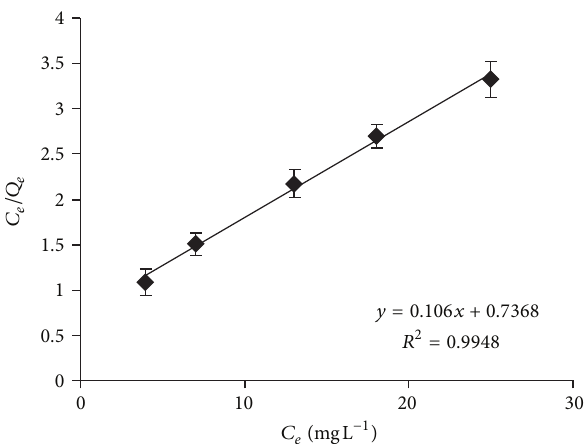
Figure 5: Langmuir isotherm plot for the adsorption of chromium into the micelle-clay complex. Contact time = 3h, temperature = 25.0 ± 0.2 ∘ C, and adsorbent dosage = 5.0g L −1 . Data represent averages of total-Cr triplicate measurements (AAS) ± SE.